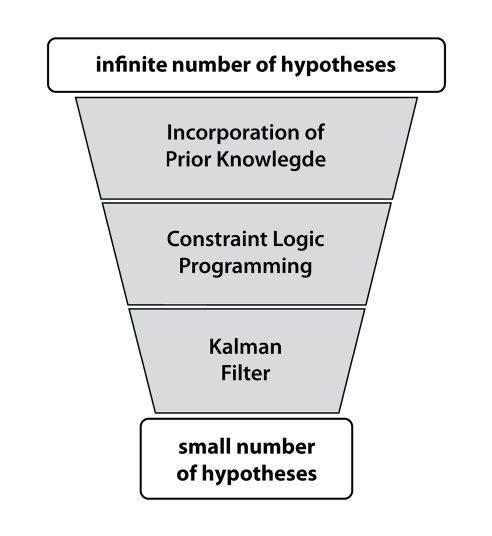
Figure 2: The presented reasoning process restricts the space of hypotheses in three reasoning steps: incorporation of prior knowledge, constraint (logic) programming and Kalman filter method is applied that enables to identify and model hierarchical structures in building footprints. Hereby axis as well as trans- lation symmetries within footprints are identified and modeled using formal grammars (Dehbi and Pl¨umer, 2011). The latter enable with a set of rules the representation of symmetry hier- archies with respect to various underlying global and local sym- metry axes. Figure 3 illustrates the axis symmetries identified from the footprint of the Poppelsdorf Castle in Bonn. The sym- metric substructures are highlighted with the same color as the underlying symmetry axis. In order to identify symmetries in footprints the concept of symmetric polylines is learned in a su- pervised way. Consequently the reasoner makes use of these in- formation as background knowledge in order to restrict the search space of